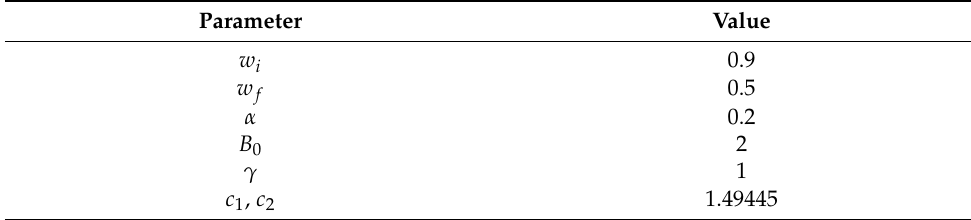
Table 1. Parameter list for PSO and FA hybrid